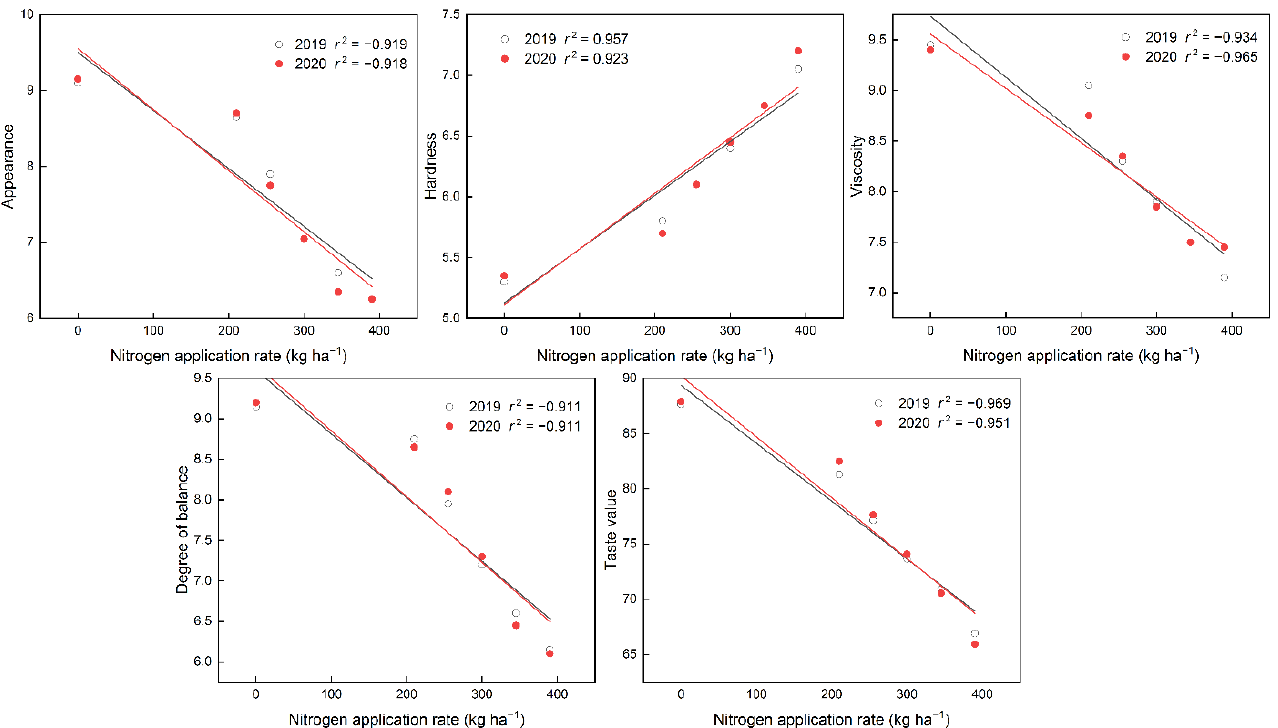
Figure 3. The correlation analysis between grain cooking/eating quality and nitrogen application rate. As shown in Table 9, the peak viscosity, trough viscosity, breakdown, and final viscosity were decreased with nitrogen rate and increased with planting density (peaked at N0D2), whereas they displayed the opposite trend in subtractive value (peaked at N390D1). No significant difference occurred at peak time and pasting temperature under varied nitrogen rate and planting density